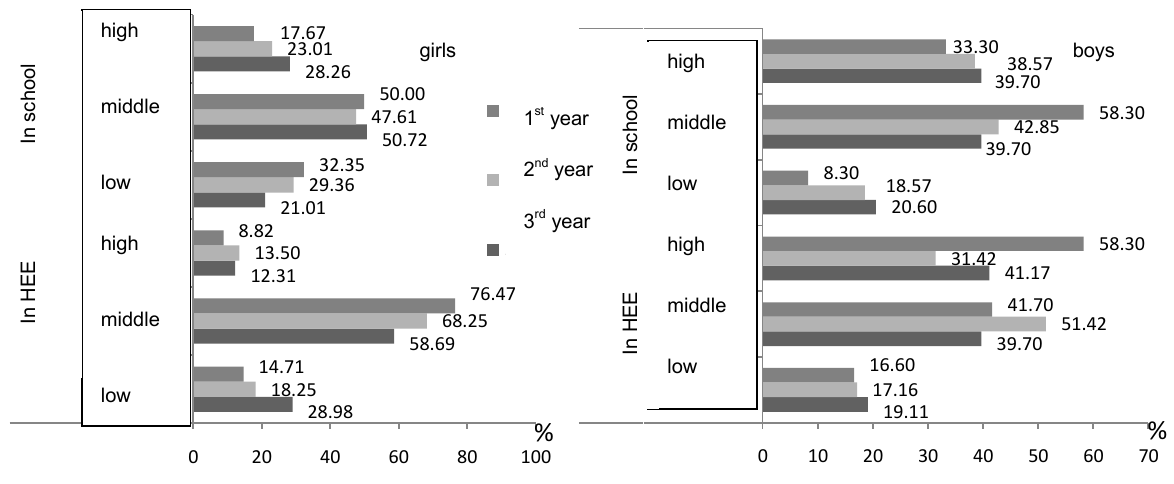
Fig.8. Interest of SRW “BelSU” students to physical culture at school and at HEE